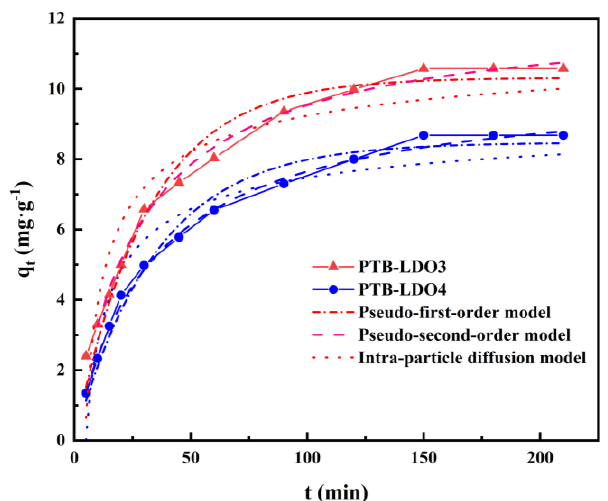
Figure 7. Effect of adsorption time on adsorption capacity and kinetic model fitting of F − for PTB-LDO3 and PTB-LDO4 (solution: 10 mg L −1 , pH = 5.5, 0.40 g L −1 dosages).